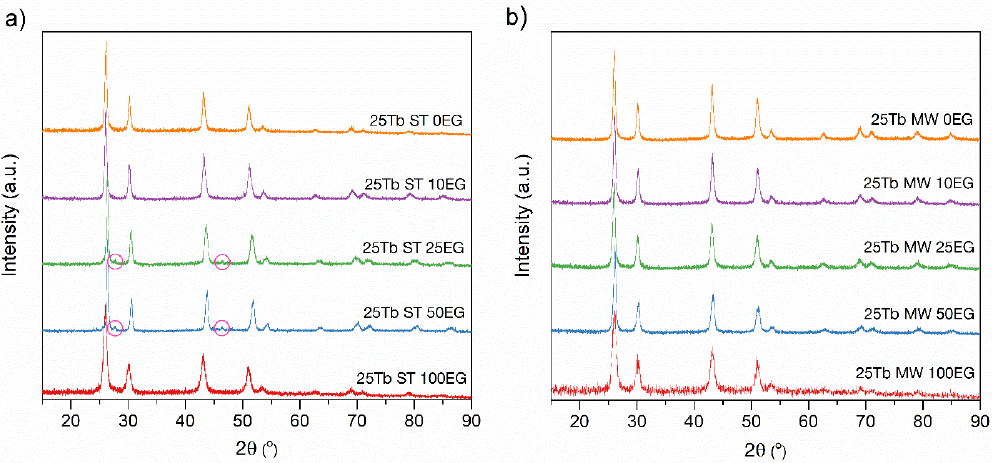
Figure 5. XRD patterns of the BaGdF 5 : 25%Tb 3+ prepared with ( a ) ST and ( b ) MW synthesis. The impurities of the GdF 3 phase marked with pink circles.